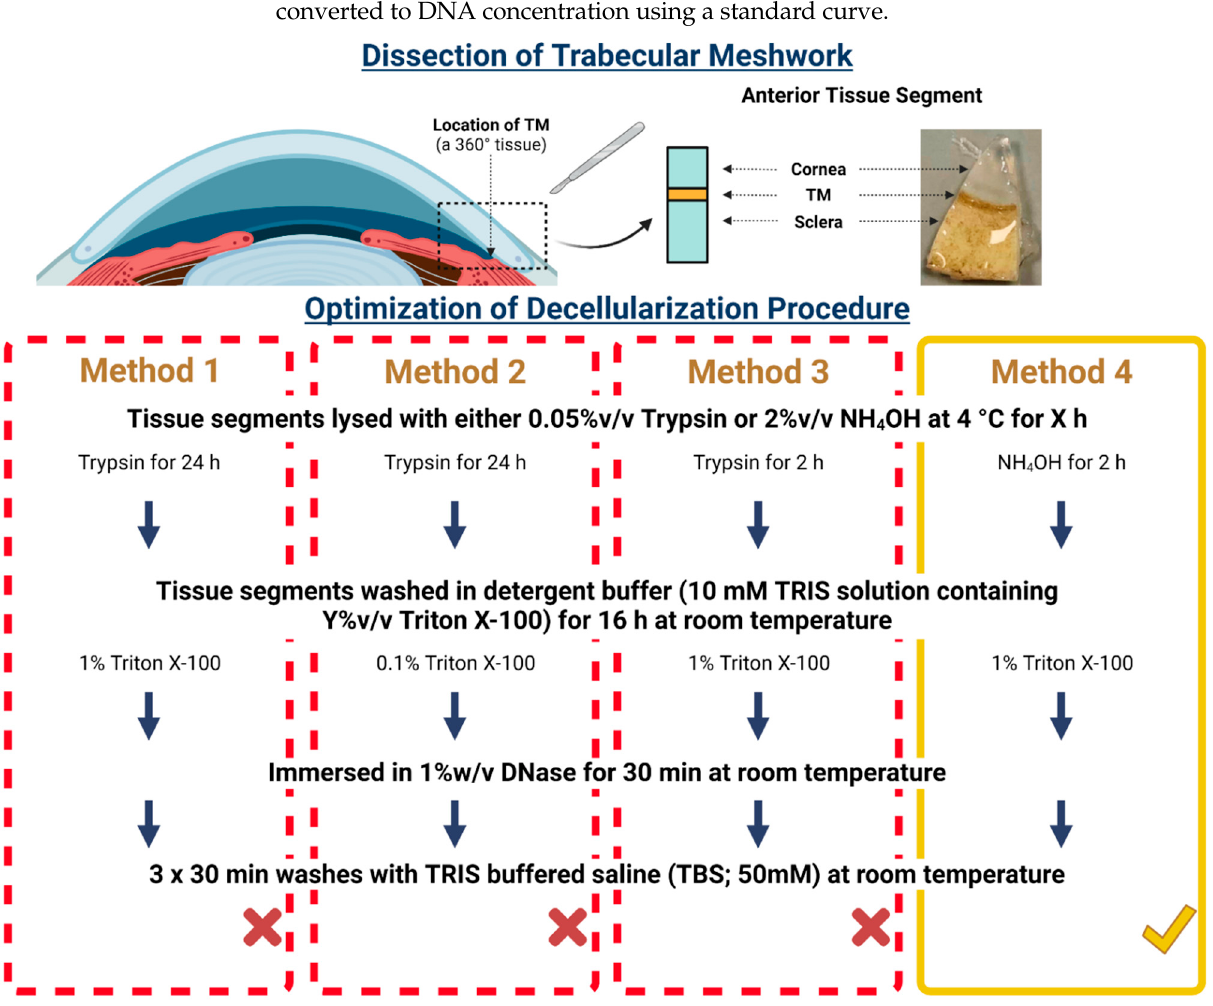
Figure 1. Schematic illustrating the different methods employed for complete decellularization of dissected bovine trabecular meshwork without compromising tissue structure. Method 4 was the optimal protocol for this tissue. Created with BioRender.com (accessed on 30 March 2022).